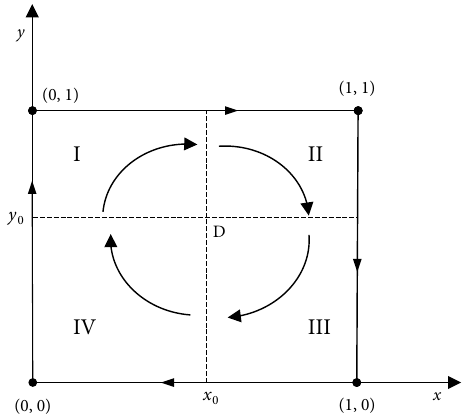
Figure 2. The dynamic diagram of the evolutionary game based on Scenario 1 of Section 4.2